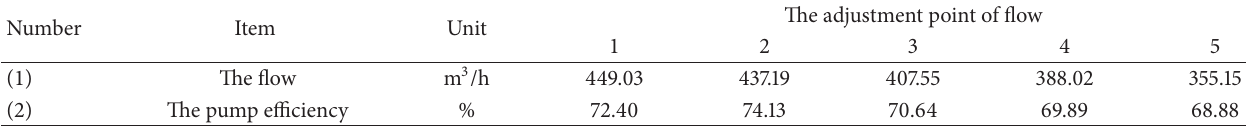
Table 2: The test data through the ultrasonic flowmeter